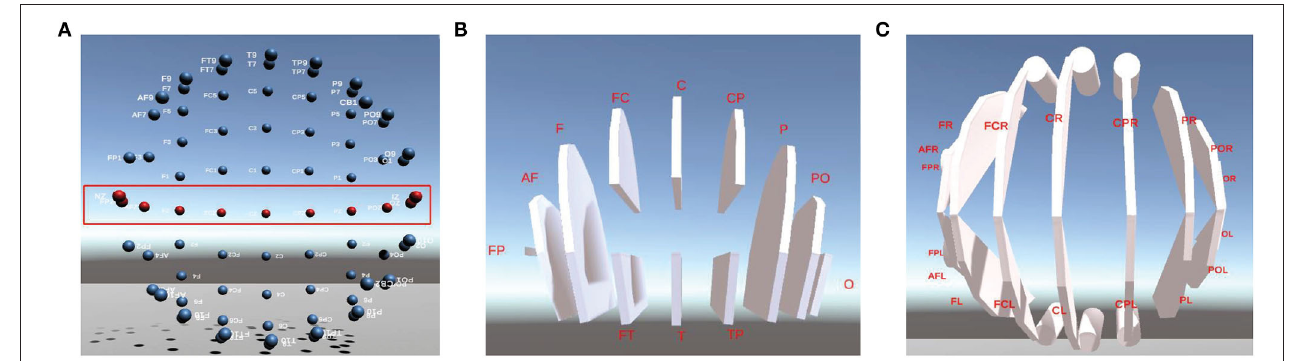
FIGURE 4 | Three ways of Visualization. (A) is the model of between-channel, (B) is the model of between-BR, and (C) is the model of between-L/RH.